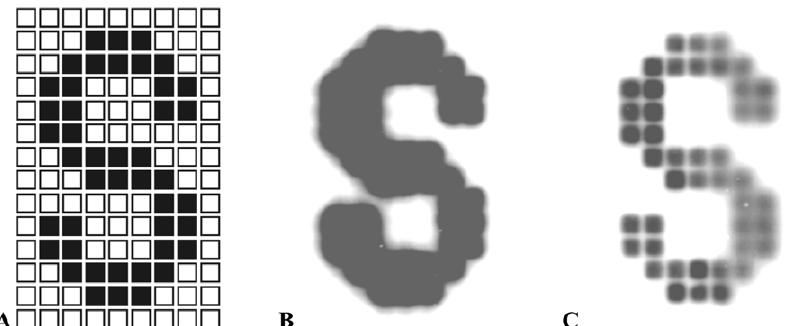
Figure 7. Patterned hybridization on an anticodon array and subsequent transfer to a chemistry array. ( A ) An anticodon array was assembled with two distinct oligonucleotide-coupled resins in the pattern of the letter S as shown in this schematic. ( B ) The anticodon array was then probed using a radiolabelled 40-mer complementary to one of the two oligonucleotides. Hybridization was performed with the mesofluidic pump. The array was imaged on a phosphor screen. ( C ) The hybridized 40-mer was transferred from the anticodon array onto an anion-exchange chemistry array using the mesofluidic Southern blotter, and imaged on a phosphor screen. Image C has finer resolution than image B because the chemistry array is much thinner than the anticodon array.